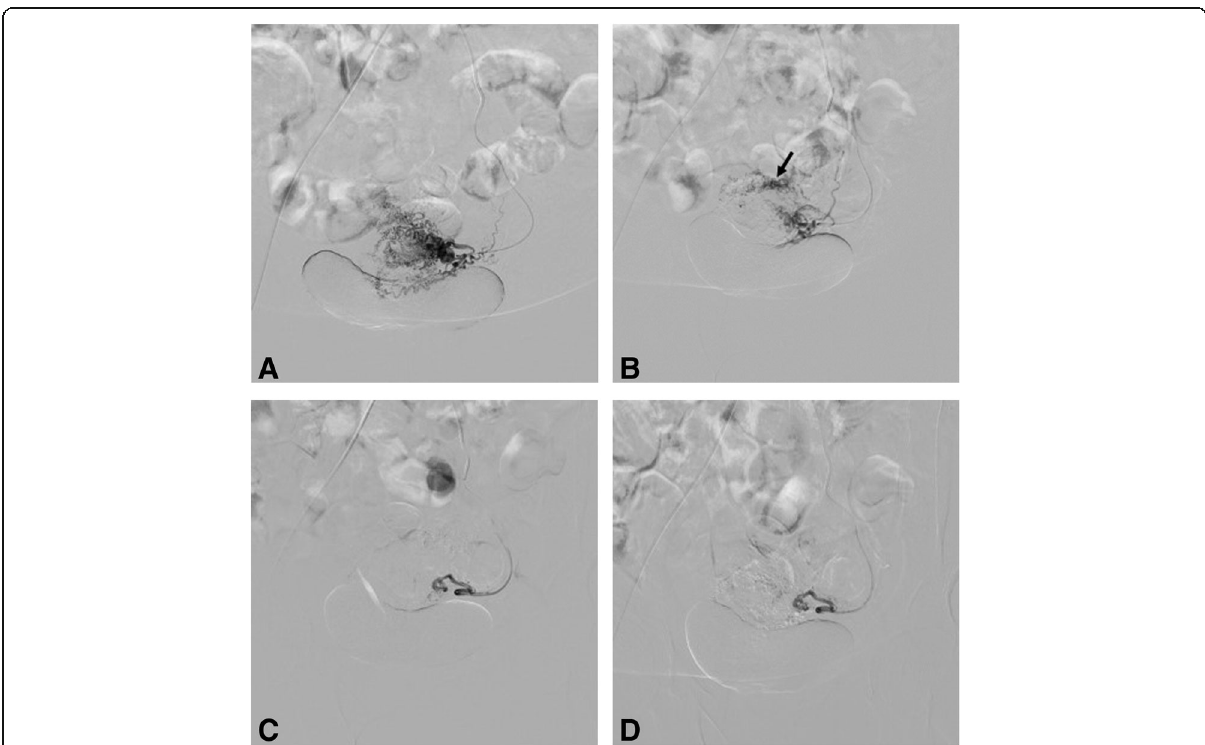
Fig. 3 Digital subtraction angiography (DSA) images (of the same patient in Fig. 2) with selective injections of the left ( a ) uterine artery demonstrate with multiple tortuous uterine artery branches and ( b ) lesion blush (most prominent at the anatomic site of the posterior uterine wall). Right uterine artery injection (not shown) was unremarkable for pathology. Post-embolization DSA images show occlusion of toursous feeding vessels ( c ) with absence of lesion blush ( d